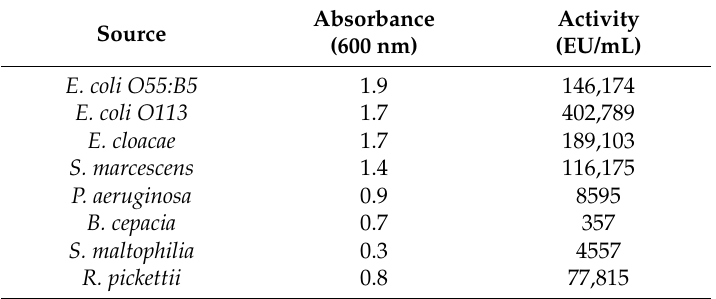
Table 1. Correlation of bacterial growth behavior and endotoxin activity. To monitor the growth of different Gram negative bacterial species ( E. coli O55:B5 , E. coli O113 , E. cloacae , S. marcescen , P. aeruginosa , B. cepacia , S. maltophilia and R. pickettii ), the OD 600 was determined before harvesting and correlated